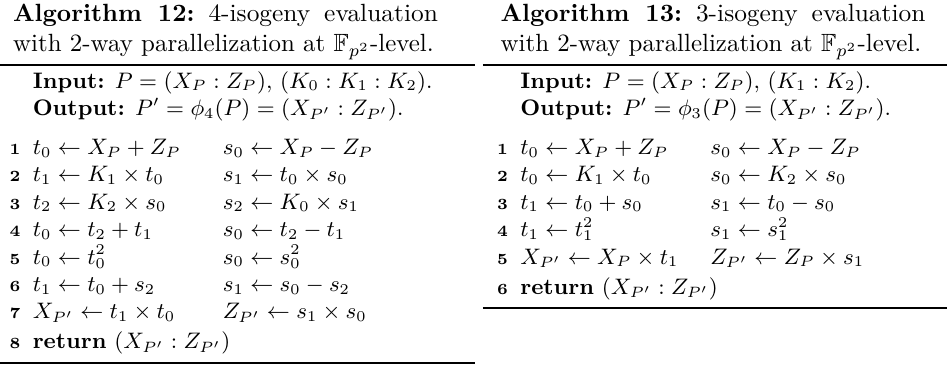
Algorithm 12: 4-isogeny evaluation Algorithm 13: 3-isogeny